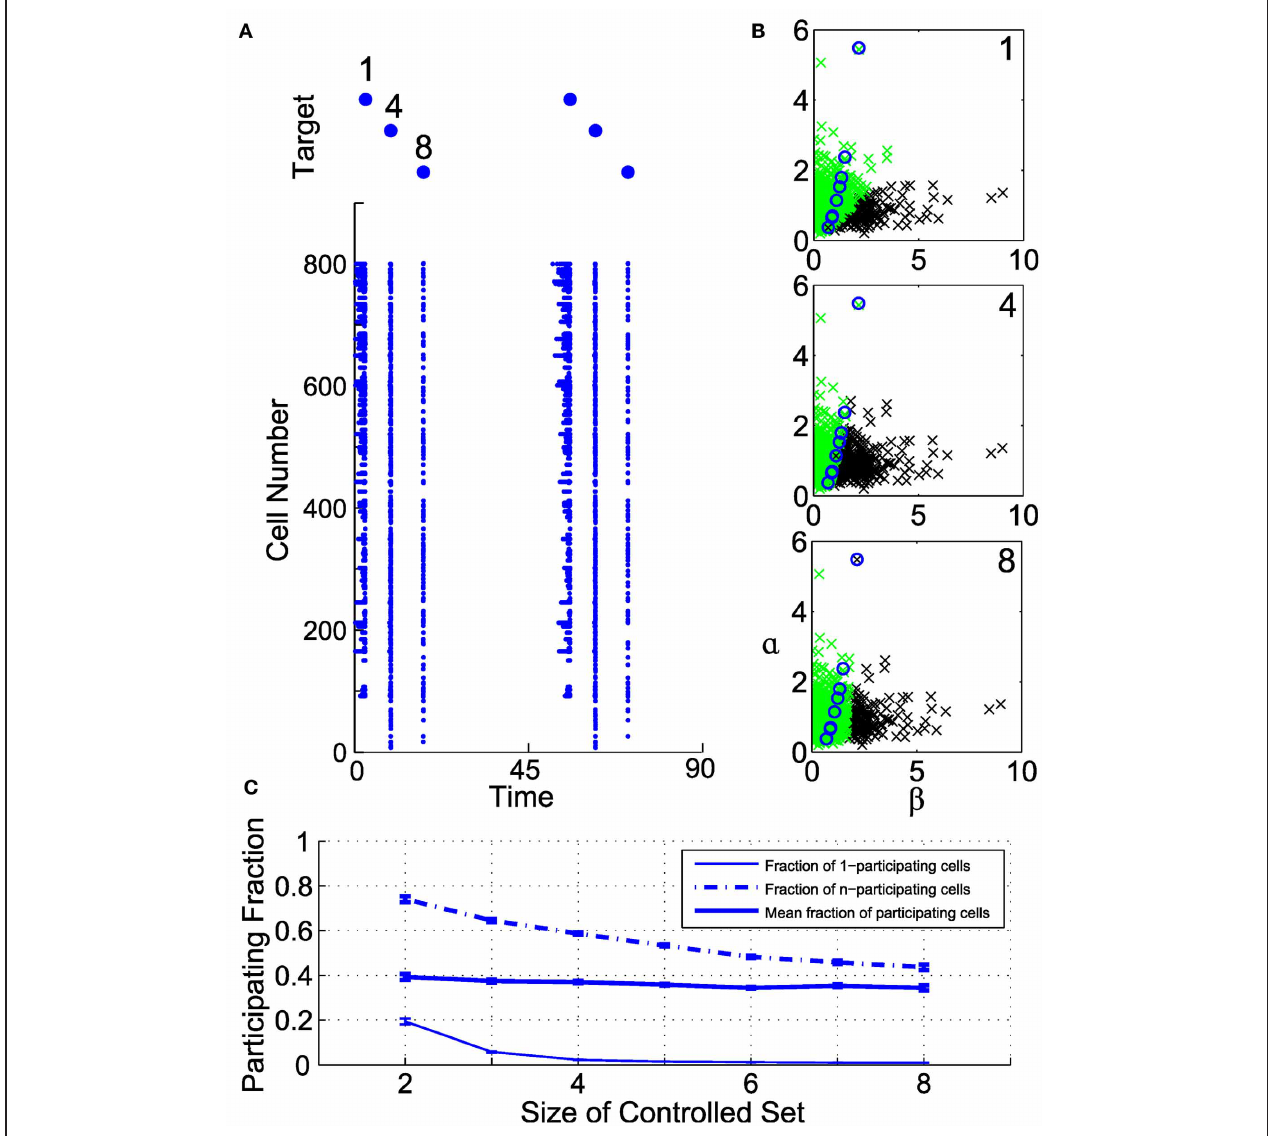
FIGURE 6 | Geometry of collateral spikes in participating subsets. ( A , top ) A target sequence in three out of a set of eight controlled cells. ( A , bottom ) Raster of corresponding spiking in superset of 800 cells. (B) Participating sets for controlled spikes, shown in the ( α , β ) plane. From top to bottom,